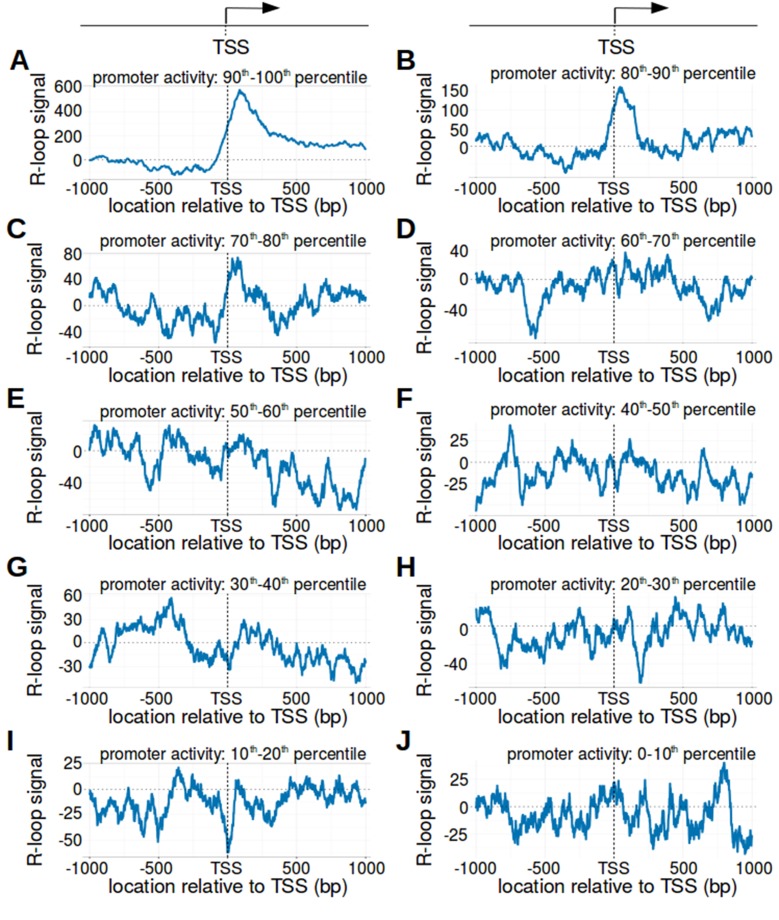
The transcription start site bounds R-loops in active promoter regions.(A–J) R-loop signal in promoter regions with different levels of promoter activity. In Figure 2C, bisDRIP-seq scores were typically greater on the non-template strand than the template strand in promoter regions with high promoter activity. We therefore wanted to know if metaplots of promoter regions varied based on promoter activity. Promoter regions were binned into ten nearly equal-sized bins based on promoter activity (n = 7821 or 7822). Metaplots with a higher promoter activity percentile have a higher promoter activity. Metaplots were generated of the R-loop signal (blue) in the promoter region of each bin: (A) ninety to a hundred percentile, (B) eighty to ninety percentile, (C) seventy to eighty percentile, (D) sixty to seventy percentile, (E) fifty to sixty percentile, (F) forty to fifty percentile, (G) thirty to forty percentile, (H) twenty to thirty percentile, (I) ten to twenty percentile, and (J) zero to ten percentile. Notably, a clear peak of positive R-loop signal downstream of the transcription start site was only observed in metaplots of promoter regions with promoter activity in the top twenty percentile (A and B). This indicates that R-loops predominantly form downstream of the transcription start site in this subset of promoter regions. Promoter activity was calculated as the mean number of sense-strand GRO-seq reads measured in the region between the transcription start site and + 1000 bp by Hah et al., 2013. R-loop signal was defined as the triptolide-sensitive template-strand bisDRIP-seq score subtracted from the triptolide-sensitive non-template bisDRIP-seq score. In each metaplot, R-loop signal at each nucleotide position was derived using the mean bisDRIP-seq score from n = 13 control-treated samples and mean bisDRIP-seq score from n = 2 triptolide-treated samples. ‘TSS’ refers to the transcription start site.